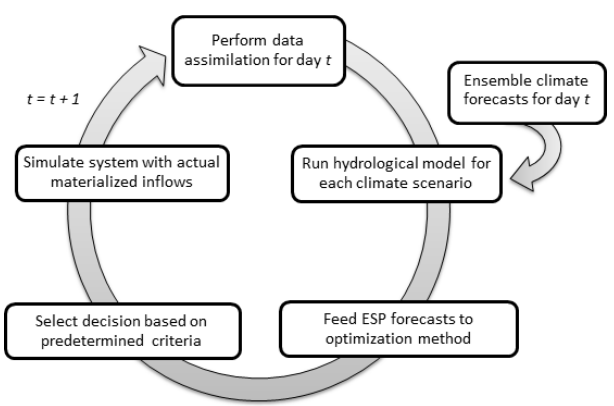
Figure 2. Over-the-loop system simulation test-bed